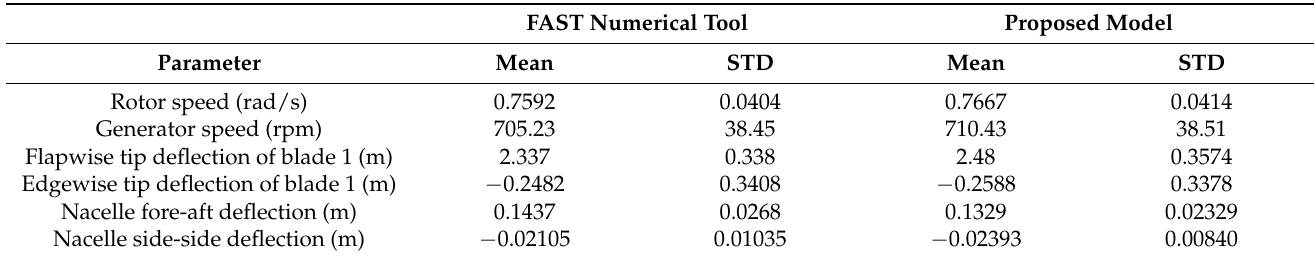
Table 1. Comparison with the performance of the aeroelastic model in this research with FAST. Mean wind speed 7 m/s and turbulence intensity 10% (region II).